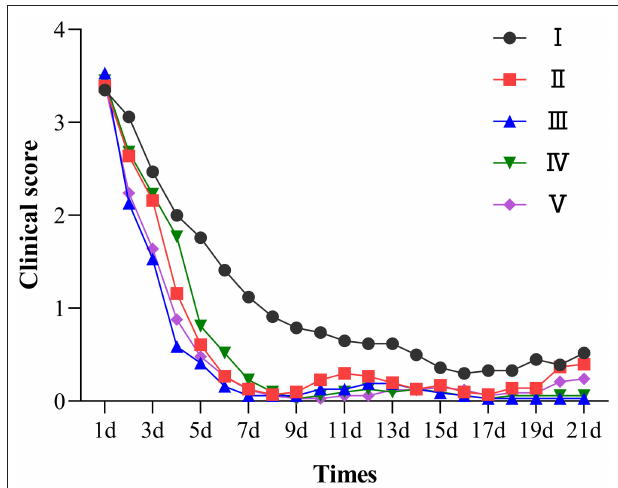
FIGURE 4 | Clinical symptom score chart of each group. I was the infection control group; II, III, IV were the low, medium, and high dose groups of chlortetracycline rumen-protected granules, respectively; V was the chlortetracycline premix group; VI was the healthy control